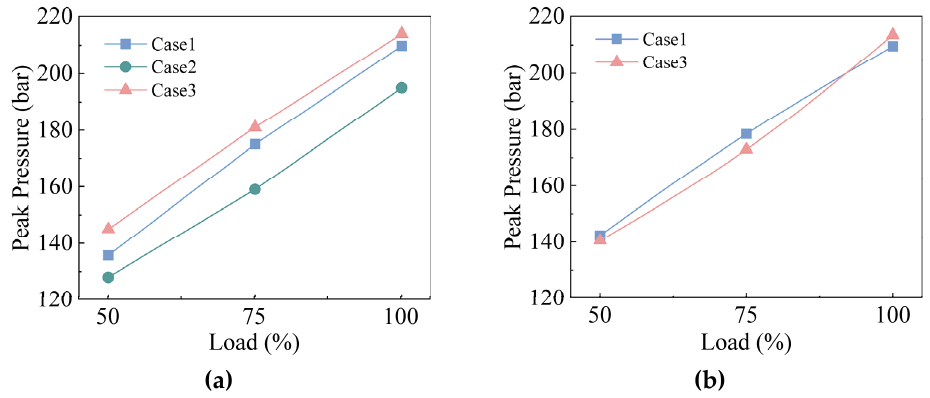
Figure 9. The trend of peak pressure for variable EBP at different loads. ( a ) EBP = 10 kPa; ( b ) EBP = 25